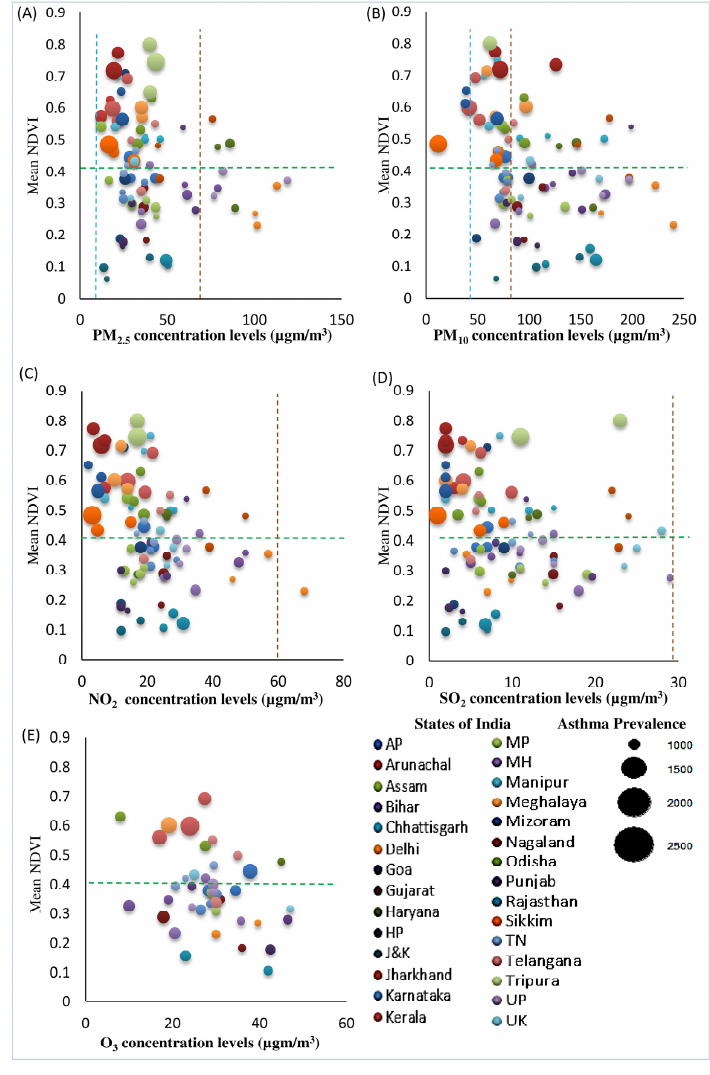
Figure 3. Mean NDVI vs. concentration of air pollutants ( A ) PM 2.5 , ( B ) PM 10 , ( C ) NO 2 , ( D ) SO 2 , and ( E ) O 3 (in µ g/m 3 ) across SUTs in the years 2005, 2011, and 2017. Note: The left panel shows the association of the mean NDVI along the Y-axis and the PM 2.5 concentration levels in the X -axis with the asthma prevalence rates across states as bubbles in the three time periods of 2005, 2011, and 2017. The right panel shows the association of the mean NDVI along the Y -axis and the PM 10 concentration levels on the X -axis with the asthma prevalence rate across states. Similarly, the middle panel on the left presents the NO 2 concentration levels, and the middle right presents the SO 2 concentration levels. The bottom left panel shows the association of the mean NDVI ( Y -axis) and changes in the concentration levels of O 3 ( X -axis) with the prevalence rate of asthma, represented as bubbles in the right panel. Each of the bubbles measures the asthma prevalence rate of each state in the three time periods. Increases in the size of the bubbles represent increases in the asthma prevalence rate and vice-versa. The colors of the bubble represent each state presented on the right side of the panel. Within the graph, the broken blue lines represent the cut-off levels for air pollutant concentration levels as per the World Health Organization (WHO) standards; the brown lines represent the cut-off levels for air pollutants as per the National Ambient Air Quality Standards, India (NAAQS), and the green lines show the mean NDVI values, above which areas show high greenspaces. Note: NDVI, normalized differential vegetation index; PM 2.5 , particulate matter of diameter 2.5 µ m or smaller; PM 10 , particulate matter of diameter 10 µ m or smaller; NO 2 , nitrogen dioxide; SO 2 , sulfur dioxide; O 3 ,